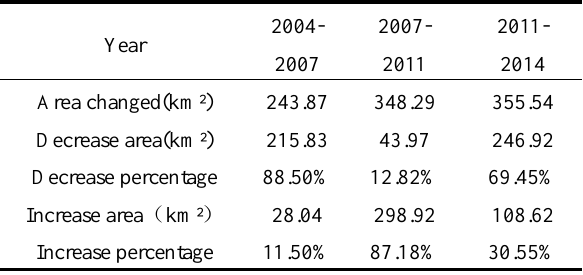
Table 2 Percentage of glacier area change type from